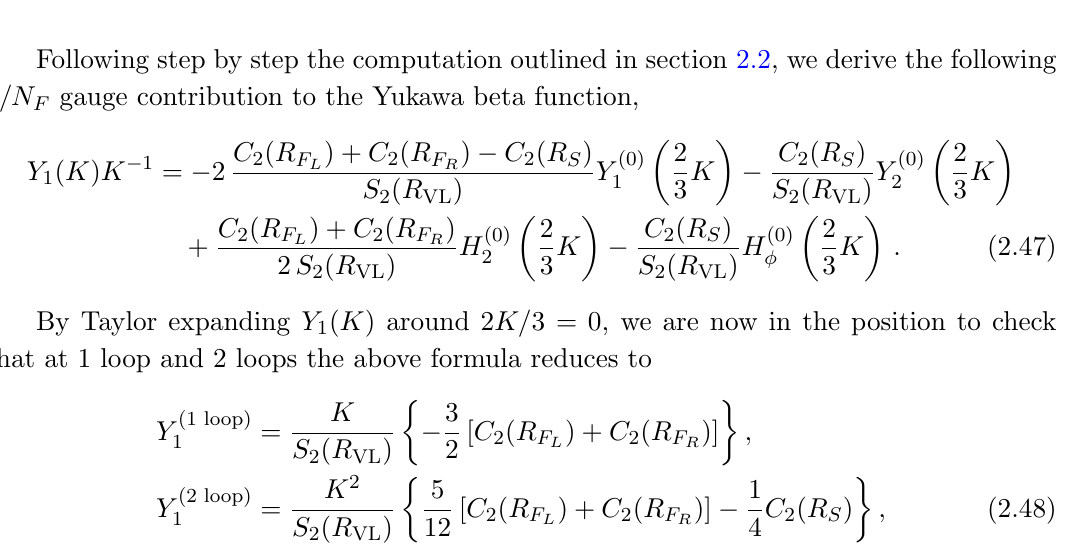
Figure 3 . A plot of the function Y 1 ( K ) =K de(cid:12)ned in eq. (2.43) for the case of the top quark Yukawa coupling (solid blue) and a model of new physics de(cid:12)ned in the text (solid red). The dashed gray line shows the function F 1 ( K ), given in eq. (2.3), for